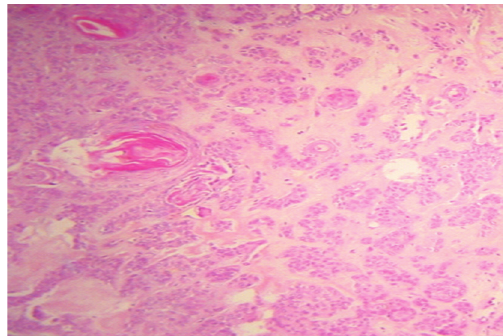
Figure 2: Histologic findings of the tumor showing the ductal epithelial and myoepithelial elements with chondromyxoid stroma ( × 8;